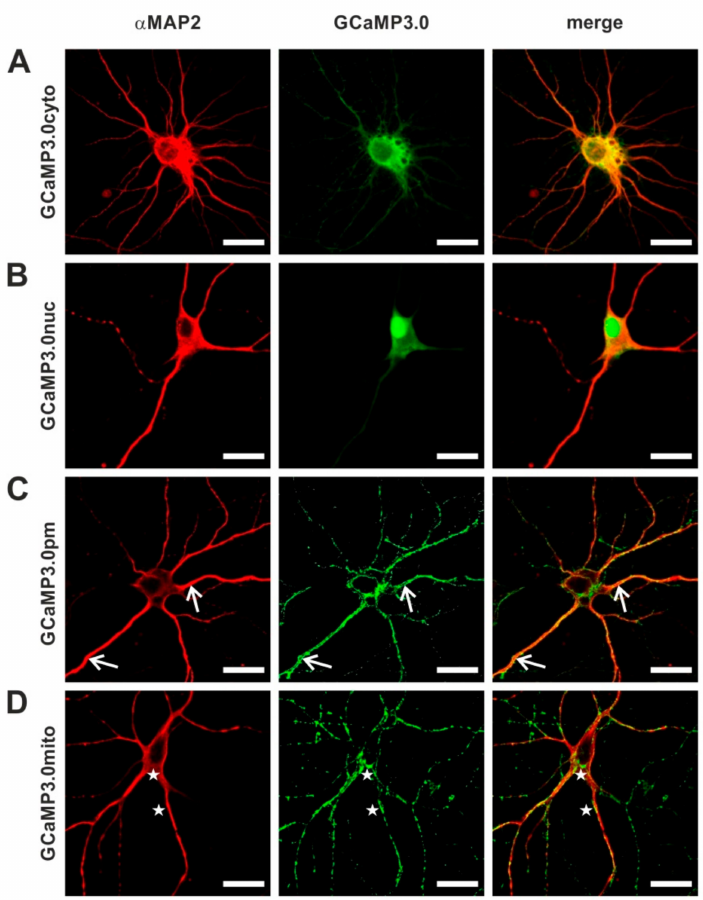
Figure 8. Distribution of GCaMP3.0 variants in primary cortical neurons. Rat embryonal cortical neurons were incubated for eight days with recombinant Adeno-associated virus preparations: ( A ) rAAV6-GCaMP3.0cyto, ( B ) rAAV6-GCaMP3.0nuc, ( C ) rAAV6-GCaMP3.0pm, and ( D ) rAAV6- GCaMP3.0mito. Samples were fixed (DIV16) and immunologically stained. Neurons were labeled with specific primary anti-MAP2 antibodies (rabbit-anti-MAP2, dilution 1:500) and secondary donkey anti-rabbit Cy3 antibodies (dilution 1:500; red). GCaMP3.0 variants were detected by their green fluorescence. Composite images are depicted on the right (merge). Subcellular localization of GCaMP3.0pm and GCaMP3.0mito is depicted with arrows and asterisks, respectively. The scale bar denotes 20 µ